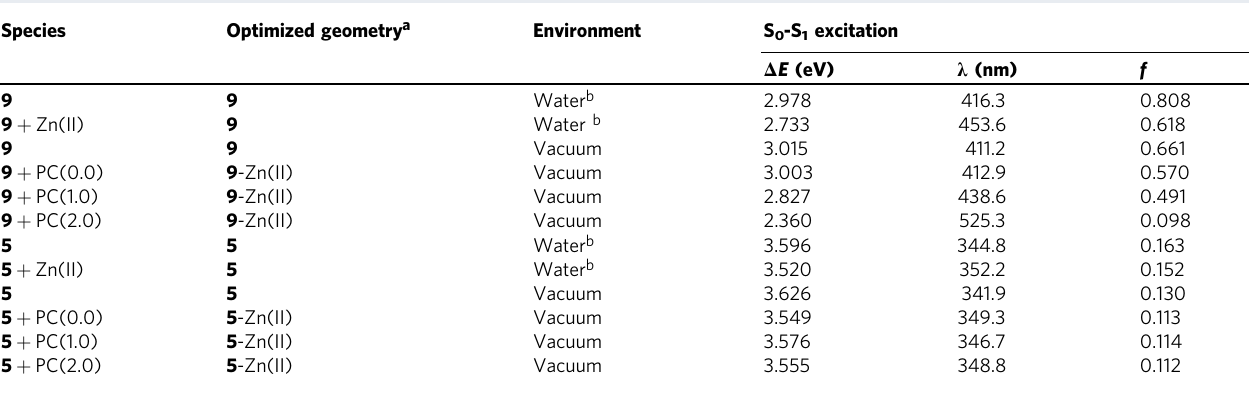
Table 3 Summary of the calculated S 0 -S 1 excitation state of the probes with or without zinc ion/positive charge (PC)